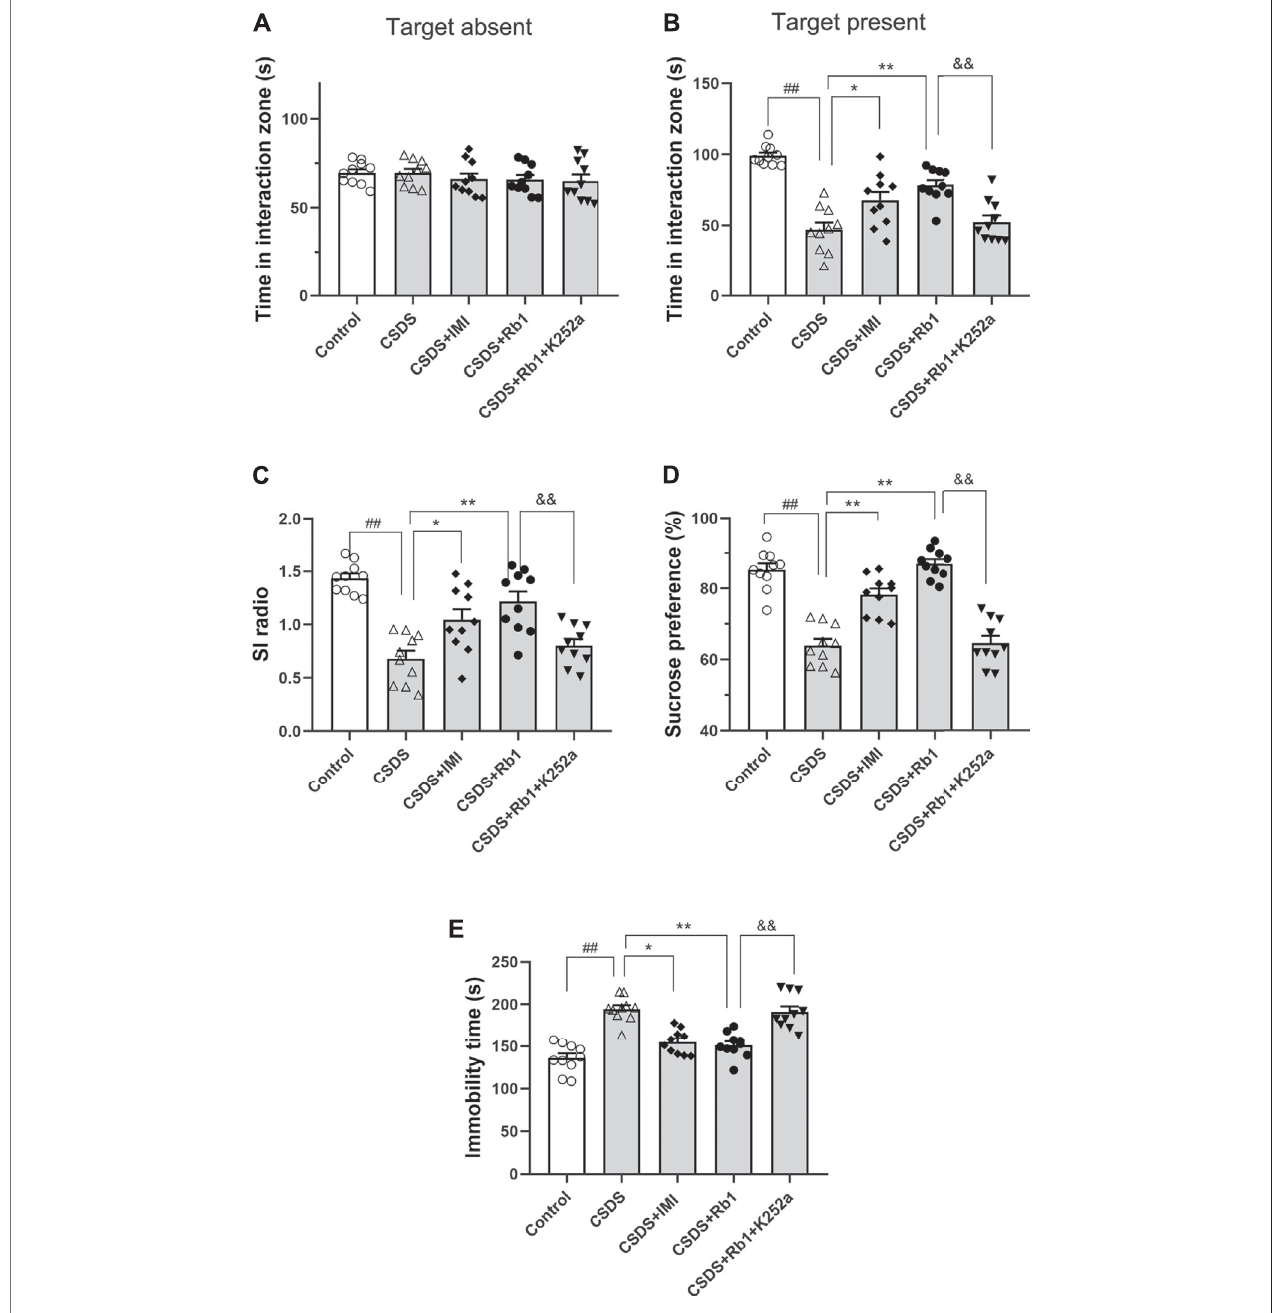
FIGURE 5 | Blockage of BDNF – TrkB signaling by K252a abolished the antidepressant activity of SY. (A – C) The time in the social interaction zone and the social interaction (SI) ratio in the SIT. (D) The intake of sucrose (in percentage) in the SPT. (E) Immobility time in the FST. The obtained results are indicated as means ± SEMs (n (cid:2) 10). # p < 0.05, ## p < 0.01, vs. the control group; * p < 0.05, ** p < 0.01, vs. the model